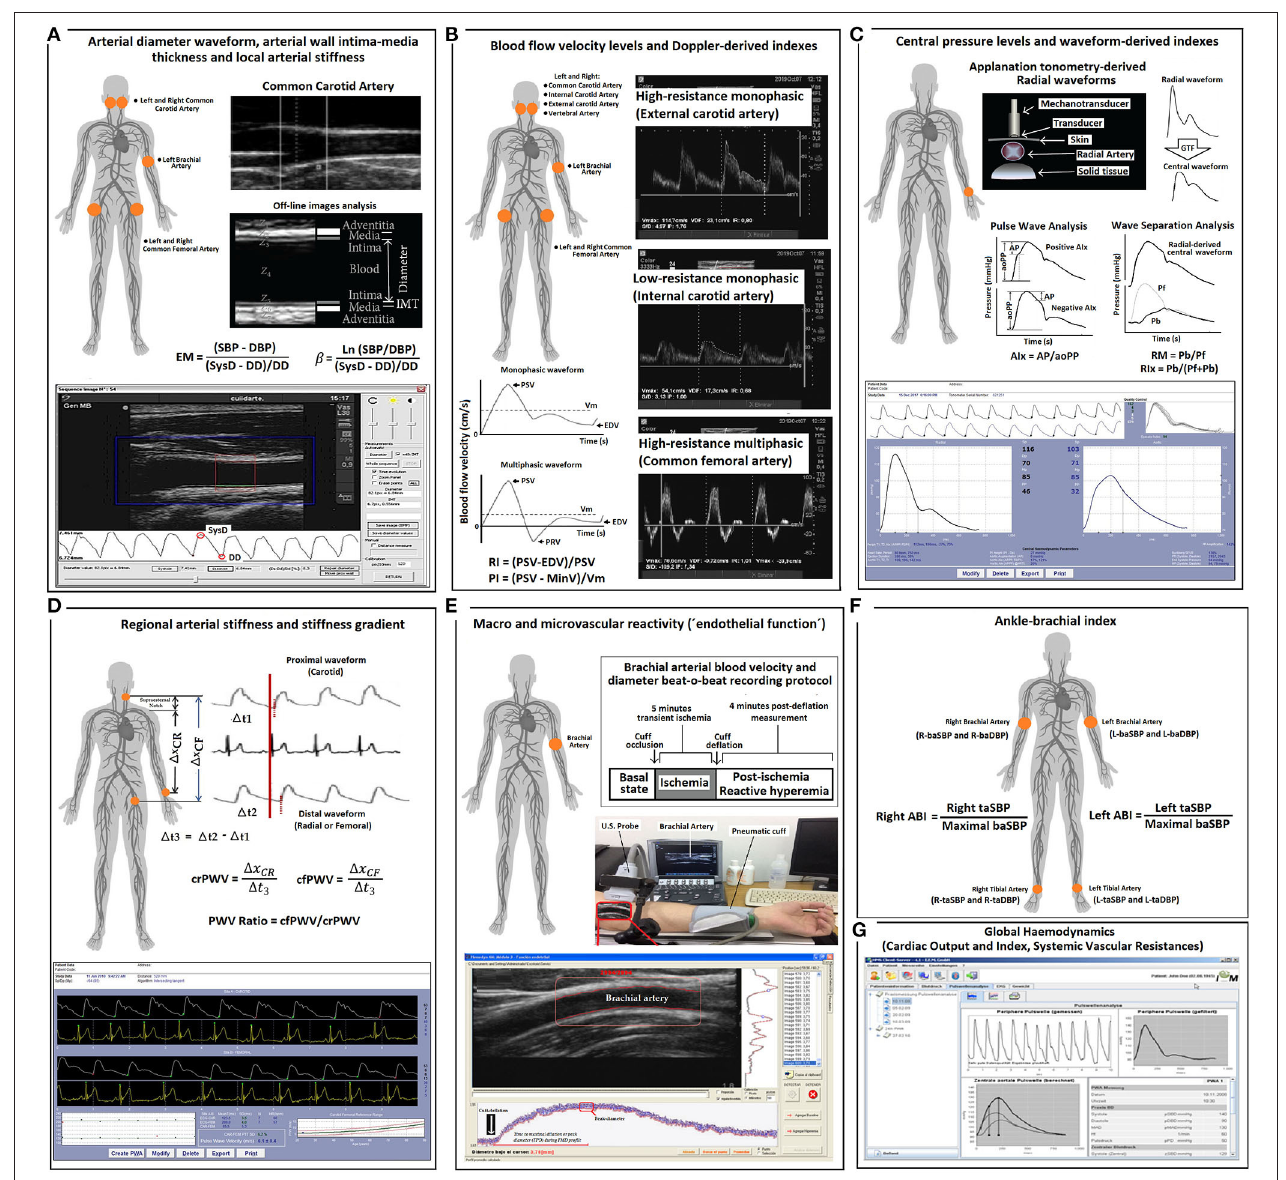
FIGURE 1 | Summary of the methodology used for cardiovascular evaluations. (A) Arterial diameter, intima-media thickness and local arterial stiffness. EM, elastic modulus; SBP and DBP, systolic blood pressure and diastolic blood pressure, respectively. SysD and DD, systolic diameter and diastolic arterial diameter, respectively; IMT, intima-media thickness; (B) Blood flow velocity levels and Doppler-derived index. PSV, peak systolic velocity; Vm, mean velocity; EDV, end diastolic velocity; PRV, peak reversal (negative) velocity; RI and PI, Doppler-derived resistive index and pulsatile index; (C) Central (aortic) pressure and aortic waveform-derived indexes.